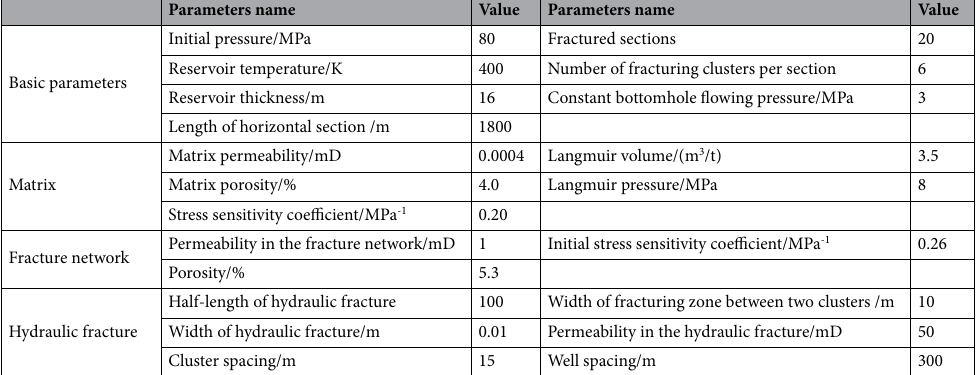
Table 3. Geological parameters and engineering parameters of an example well.